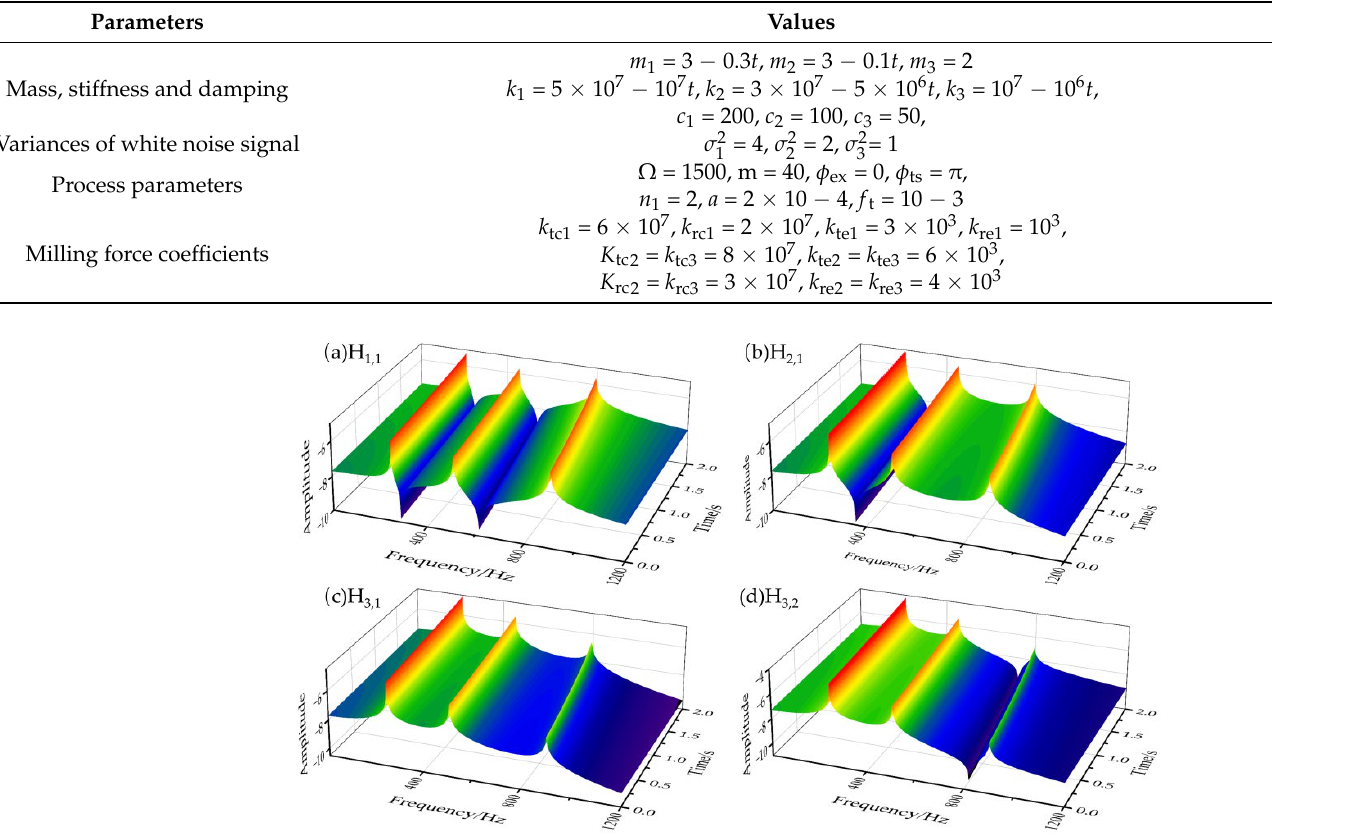
Figure 4. Frequency response functions of the 3-DOF time-varying structure.